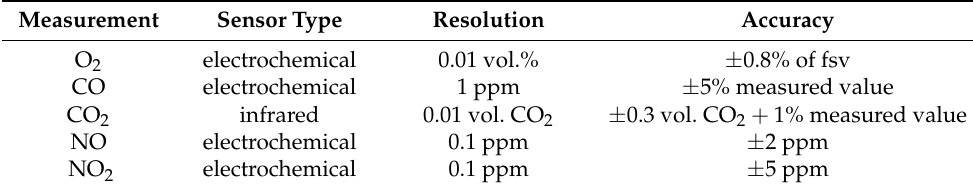
Table 1. Parameters of the sensors used to measure the